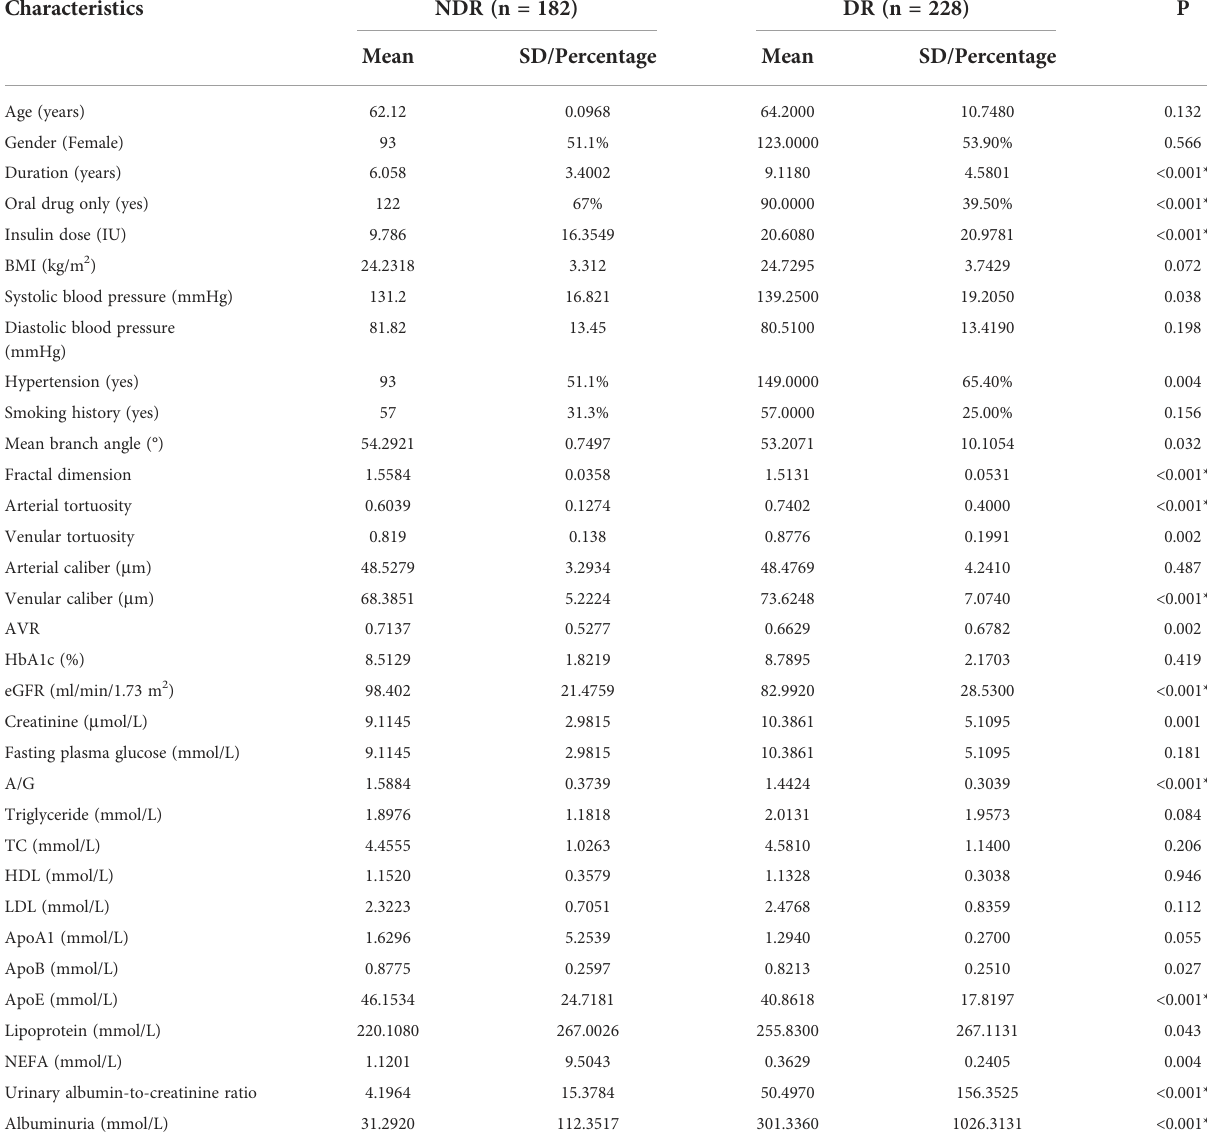
TABLE 1 Characteristics of the patients in the NDR and